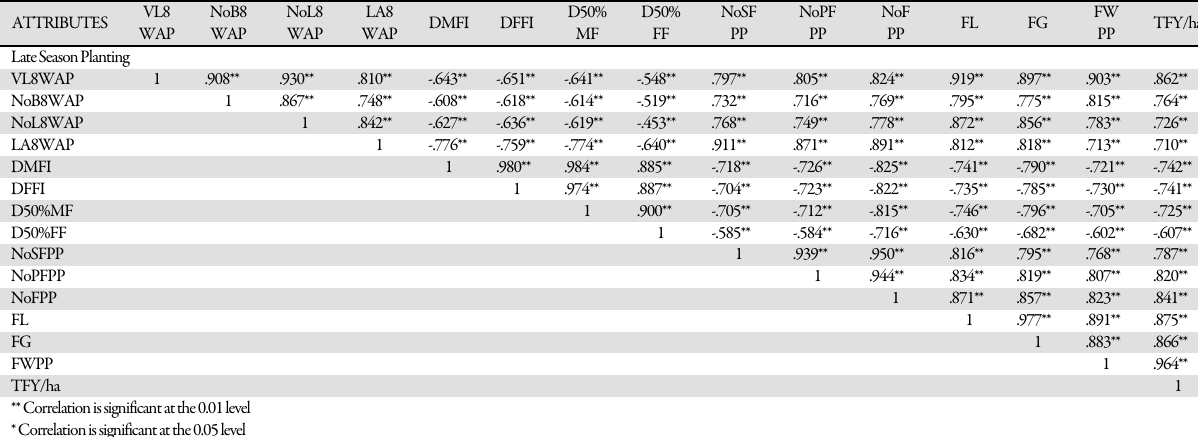
Table 7. Correlation coefficient for 15 traits of cucumber genotypes evaluated in 2014 late planting season